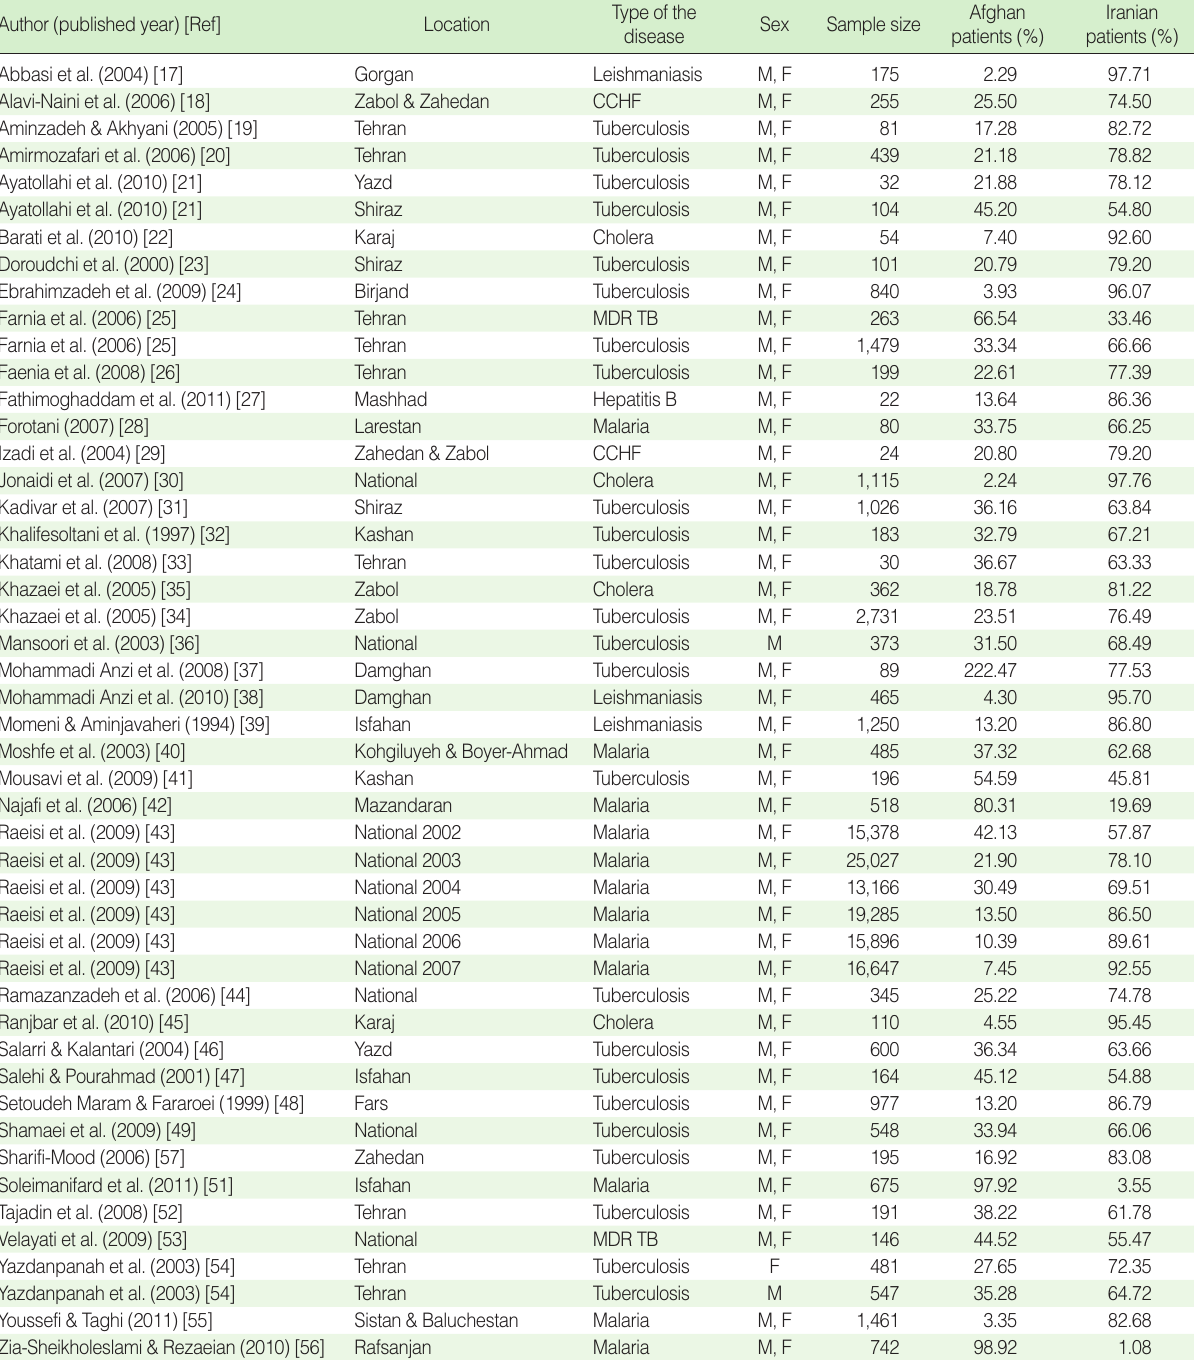
Table 1. Characteristics of the included studies in